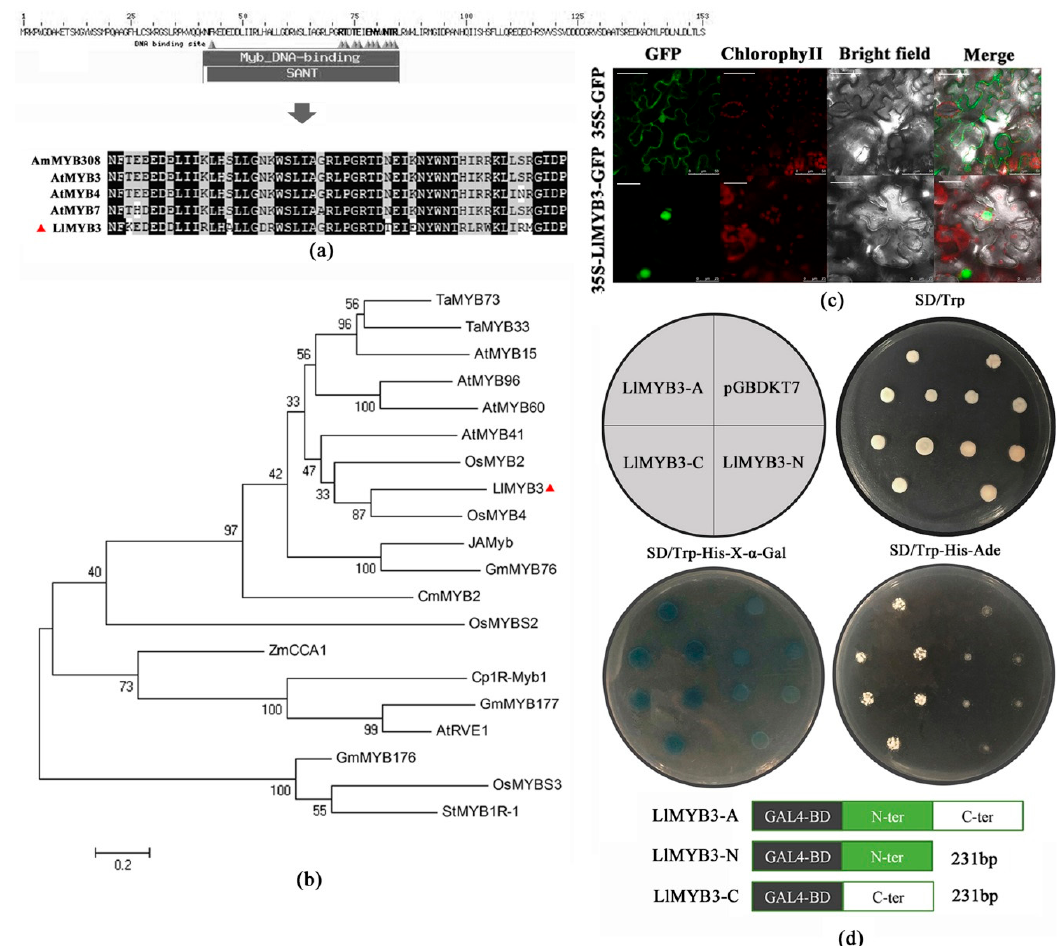
Figure 1. Characterization of tiger lily LlMYB3 protein. ( a ) Alignment of LlMYB3 with Antirrhinum majus AmMYB308, Arabidopsis AtMYB3, AtMYB4 and AtMYB5. The conserved MYB domain is marked and identical amino acids are shaded in black. ( b ) Phylogenetic tree analysis of LlMYB3 with other known stress-responsive MYB proteins. The LlMYB3 is marked with red triangle. ( c ) GFP and GFP-LlMYB3 fusion proteins were transiently expressed in tobacco leaves under control of the CaMV35S promoter and observed under a laser scanning confocal microscope. Scale bars for 35S-GFP, 50 µ m; for 35S-LlMYB3-GFP, 25 µ m. ( d ) Full-length protein (LlMYB3-A), N-terminal fragment (LlMYB3-N) and C-terminal fragment (LlMYB3-C) were fused with GAL4 DNA binding domain and expressed in yeast strain Y2HGold. The pGBDKT7 vector was used as a negative control. Transformed yeasts were dripped on the SD / -Trp, SD / -Trp-His-x-gal and SD / -Trp-His-Ade, after being cultured for 3 days in the growth